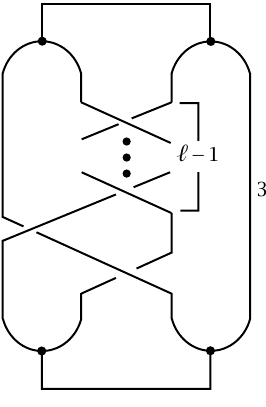
Figure 5.3 . The singular set of b( 4 (cid:2) − 2 ,(cid:2))( 2 , 3 )/ (cid:4) σ (cid:6)